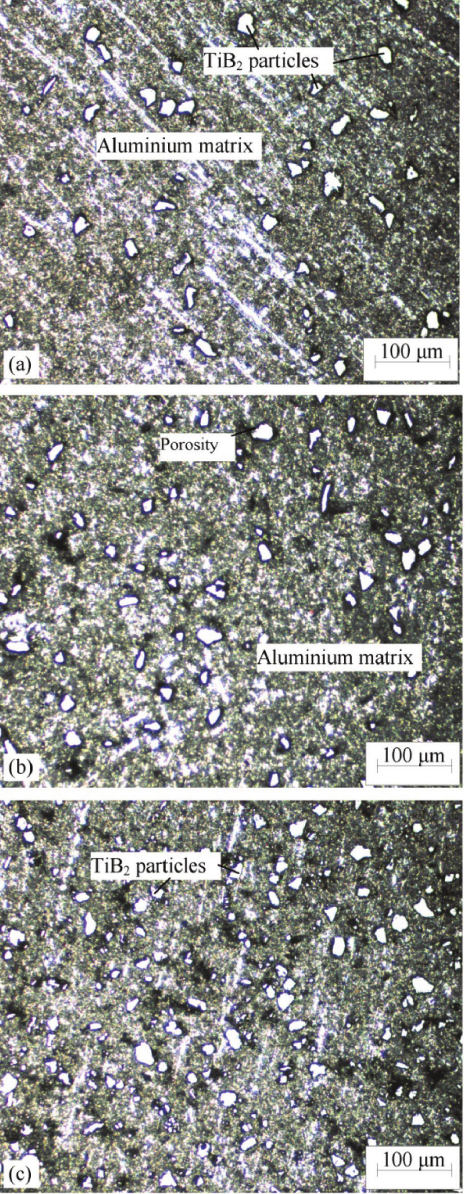
Fig. 3: Microstuctures of the Al 2014-TiB 2 composites infiltrated at 800 °C: (a) 2% TiB 2 , (b) 4% TiB 2 and (c) 8% TiB 2